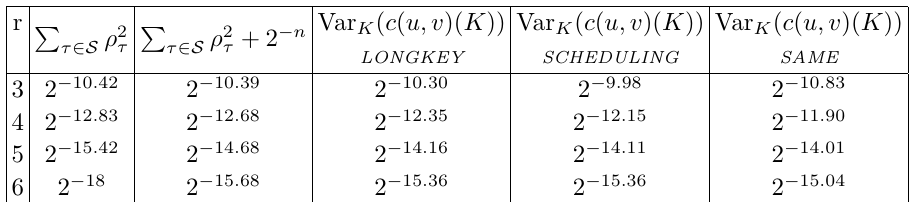
Table 1: Variance of the correlation of the linear trail with u = v =